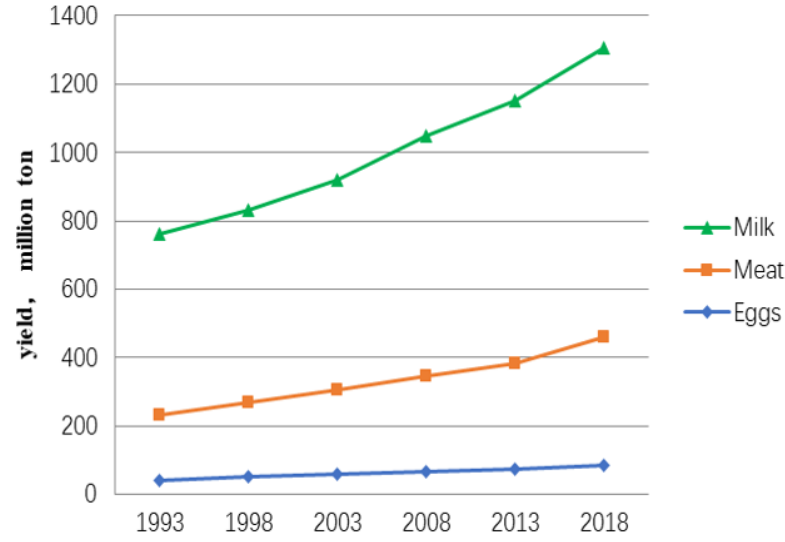
Figure 1. The yield of milk, meat, eggs in the past 30 years (FAO). 2. The Nutritional Components of the Agro-Industry By-Products